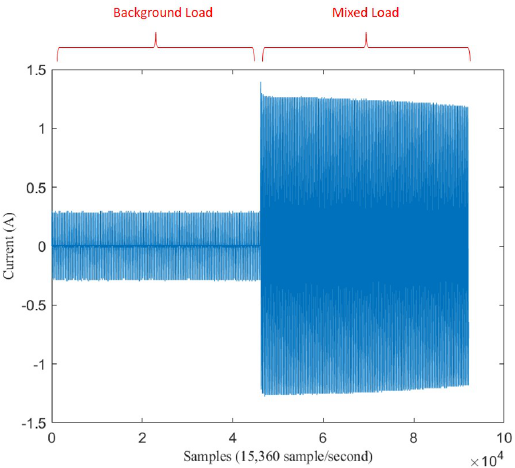
Figure 1. Six seconds of mixed load between LED Lamp and